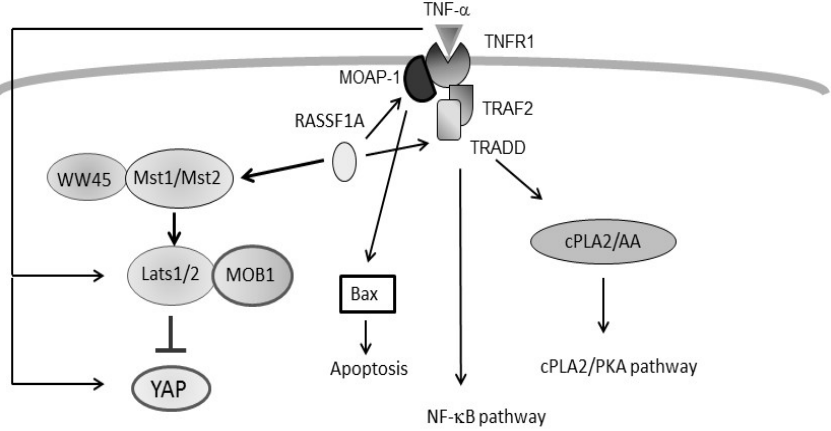
Figure 3. Schematic diagram of the interaction between TNF-α and the Hippo signalling